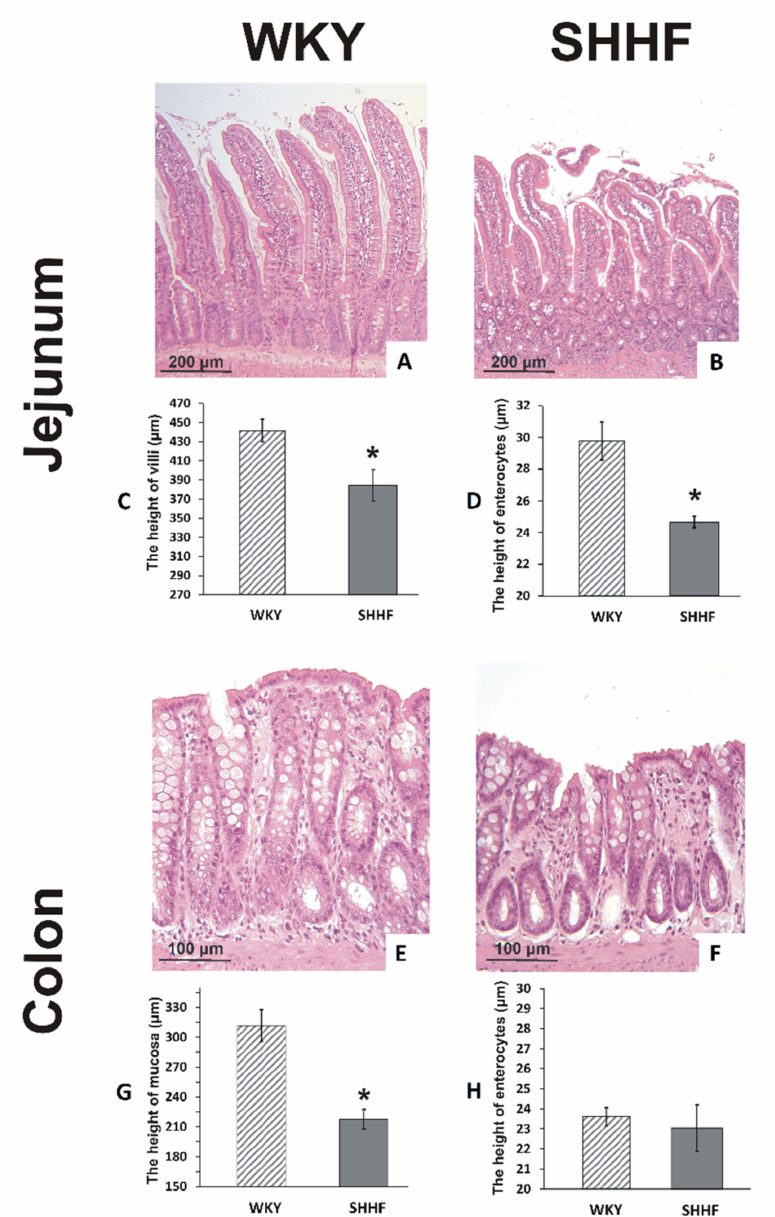
Figure 2. Histopathological evaluation of the intestine. ( A , B ) Histological images of the mucous membrane of the jejunum; ( E , F ) Histological images of the mucous membrane of the colon; stained with hematoxylin-eosin stain and viewed at a × 10 magnification (lens). ( C ) The height of the villi of the jejunum in WKY ( n = 5) and SHHF ( n = 6). ( D ) The height of enterocytes in the jejunum in WKY ( n = 5) and SHHF ( n = 6). ( G ) The height of the colonic mucosa in WKY ( n = 5) and SHHF ( n = 5). ( H ) The height of enterocytes in the colon of WKY ( n = 5) and SHHF ( n = 5). Means ± SE, * p < 0.05 by t